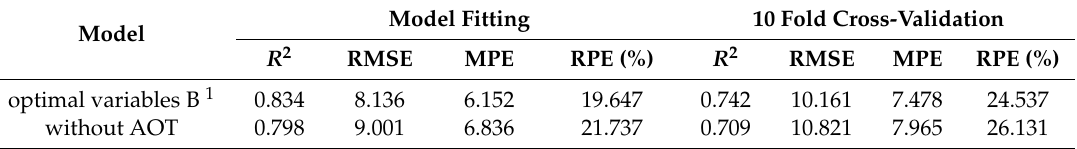
Table 2. Model validation using Sample set